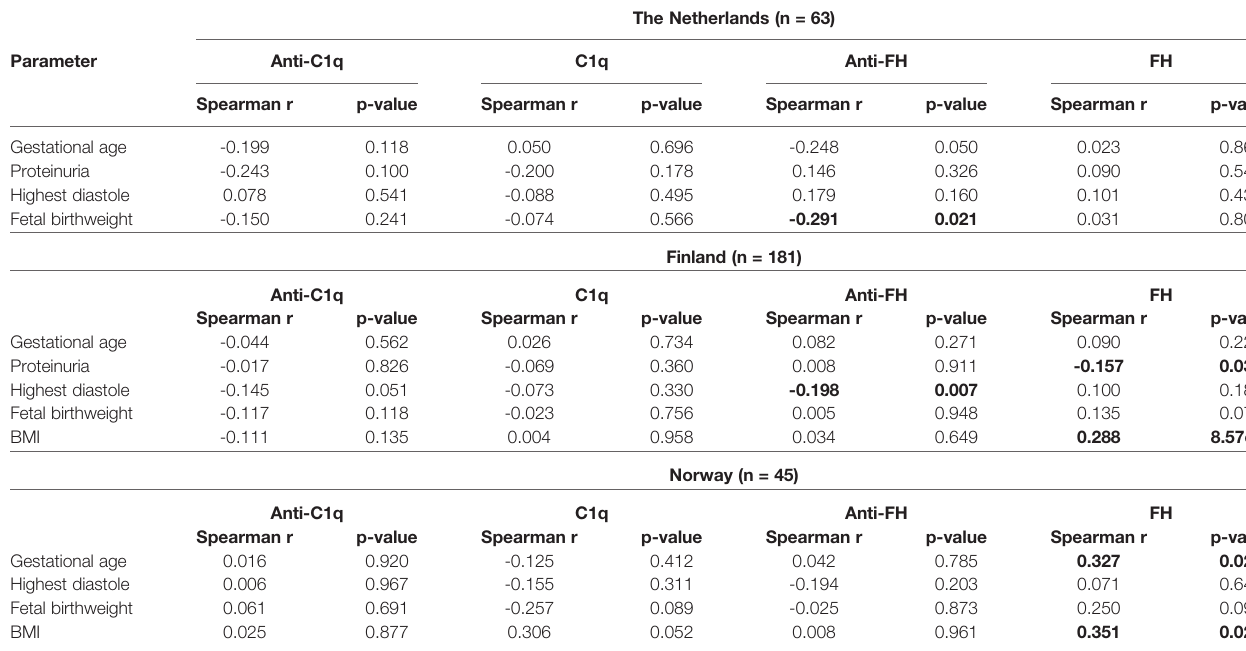
The Netherlands (n = 63)